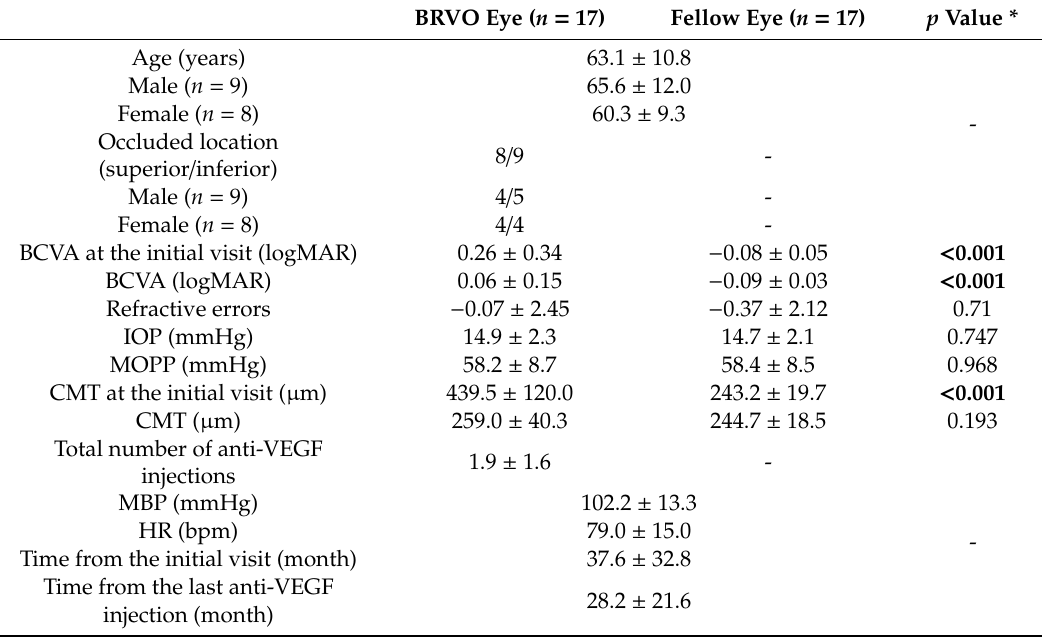
Table 1. Demographics of the study